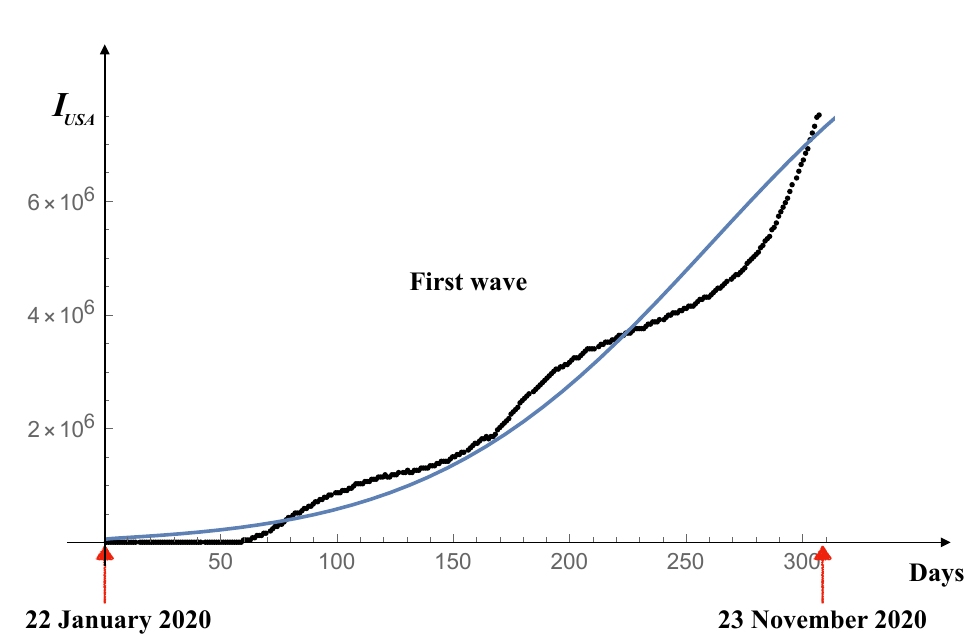
Figure 22. Comparison between theoretical predictions (blue line) and real data (black dots) for USA by assuming that US is still in the first wave of Coronavirus. The values of the parameters are; ˜ α = 0.021 day − 1 , β = 0.095 day − 2 , K = 25,000,000, and t L = 54 days, respectively.